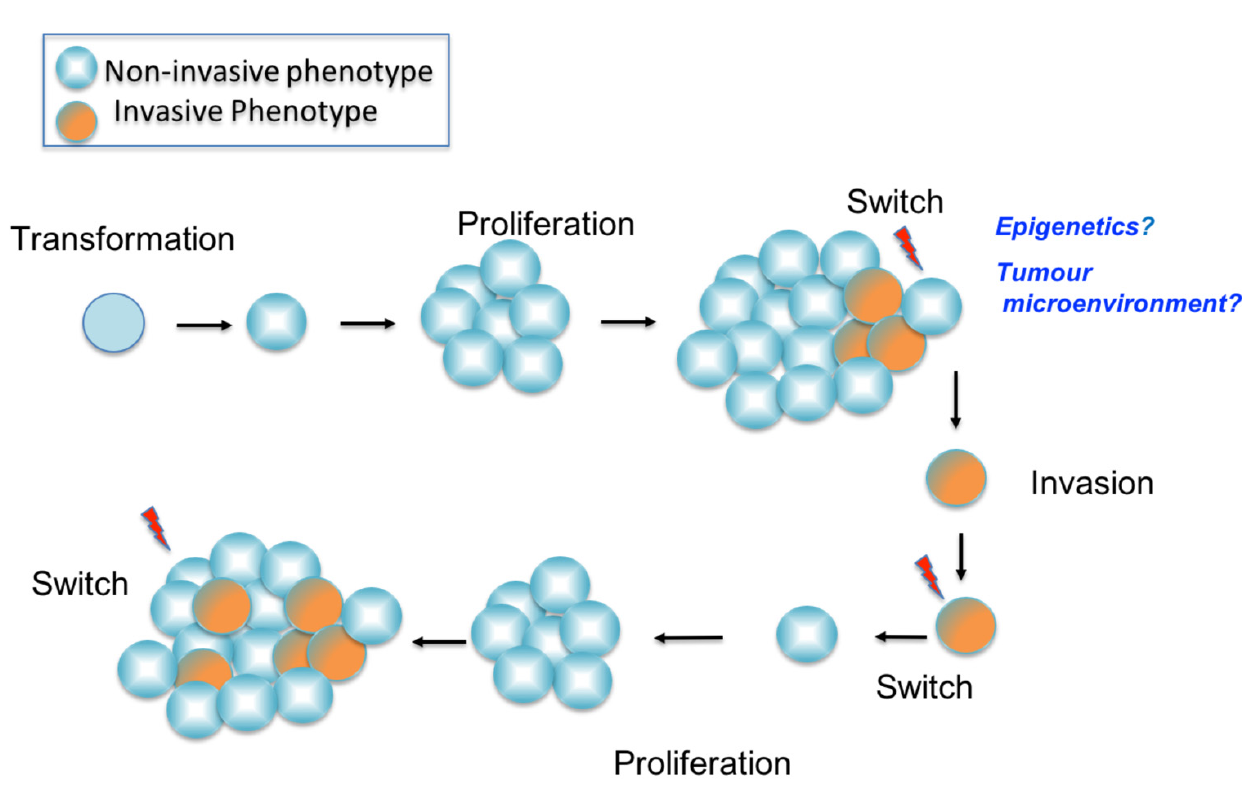
Figure 5. Phenotype switching in melanoma. In the early phase melanoma cells show a non-invasive phenotype with proliferative characteristics. Following this a hypothetical switch, brought about by the factors in the tumour microenvironment such as hypoxia or inflammation, or perhaps by epigenetic changes, gives rise to a phenotype with a high invasive capacity. The invasive cells escape the primary site and upon reaching a suitable distant site, revert to the non-invasive phenotype and the cycle is repeated. Each switch in phenotype is accompanied by the expression of a gene signature specific to each phenotype.